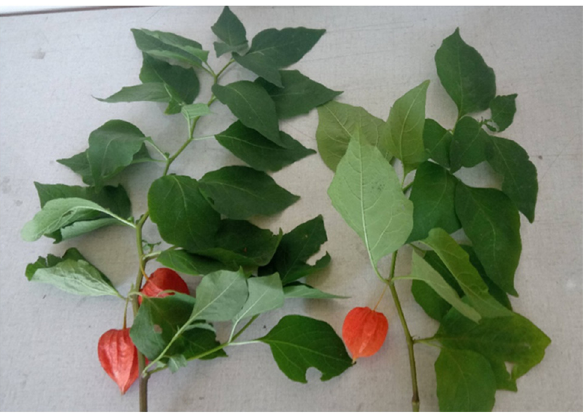
Figure 1: Fresh leaves and stems of P. alkekengi ( photo by authors )